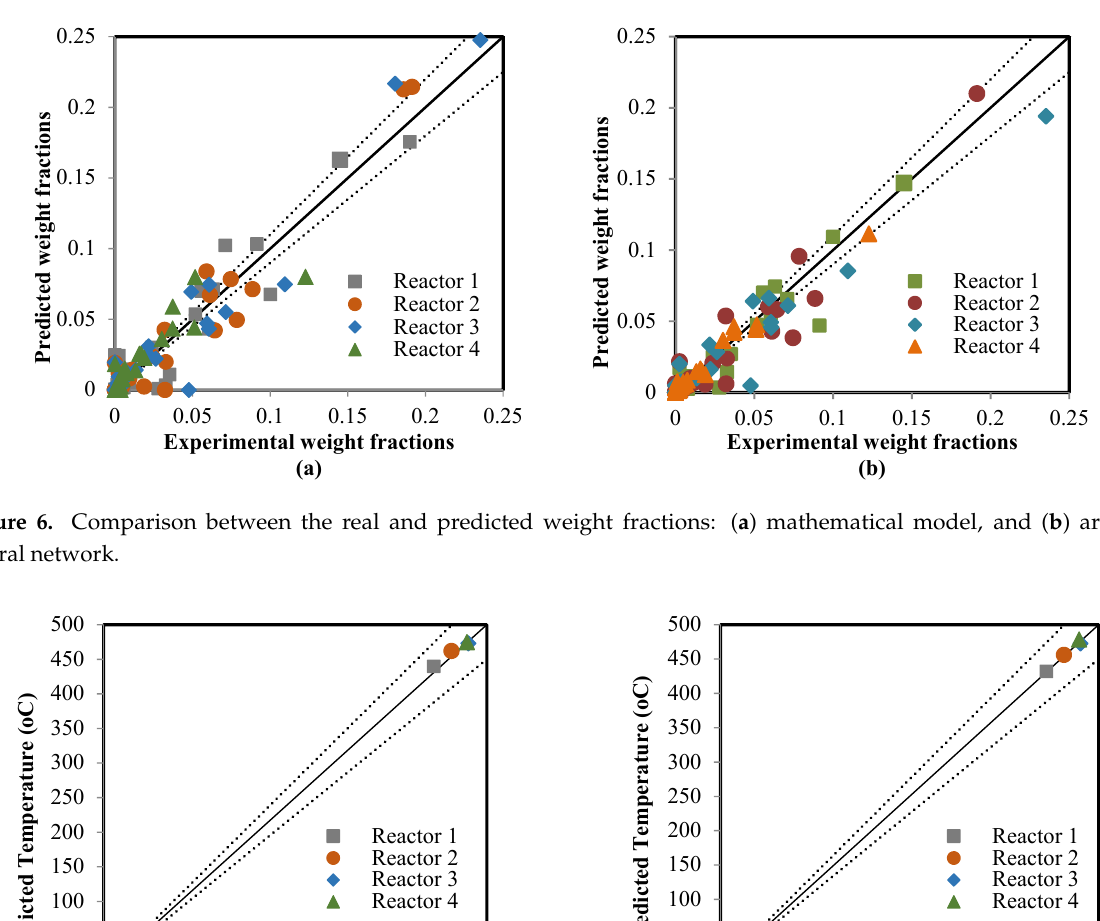
Figure 8. Comparison between the real and predicted pressure: ( a ) mathematical model, and ( b ) artificial neural network. Table 6. Summary of the estimated errors. Mathematical Model